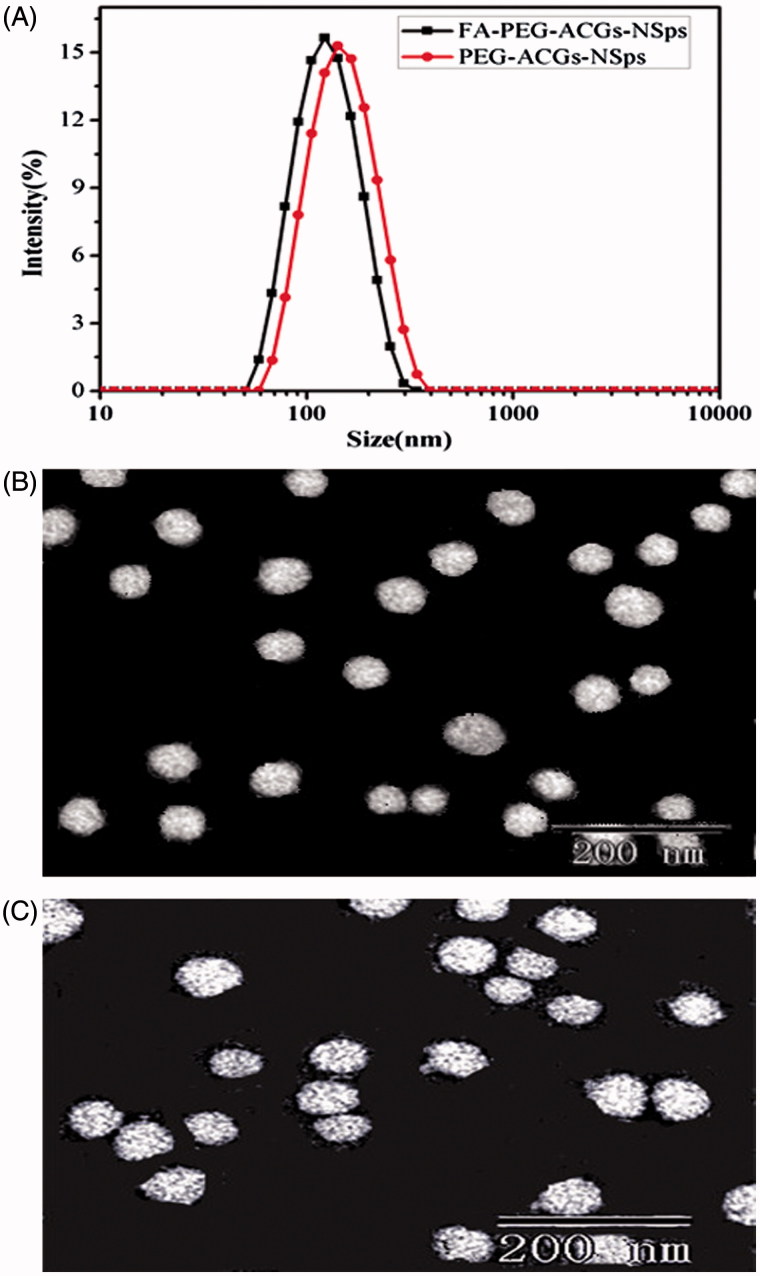
The particle size distribution and morphology of ACGs-NSps. (A) The particle size of FA-PEG-ACGs-NSps and PEG-ACGs-NSps measured by DLS. (B) TEM micrograph of FA-PEG-ACGs-NSps. (C) TEM micrograph of PEG-ACGs-NSps.